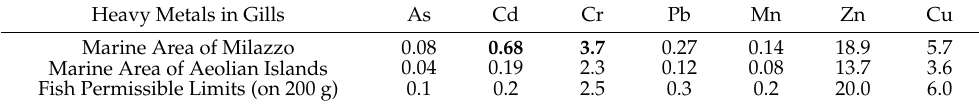
Table 4. Permitted limits of heavy metal concentrations over 200 mg in the gills of Boops boops .